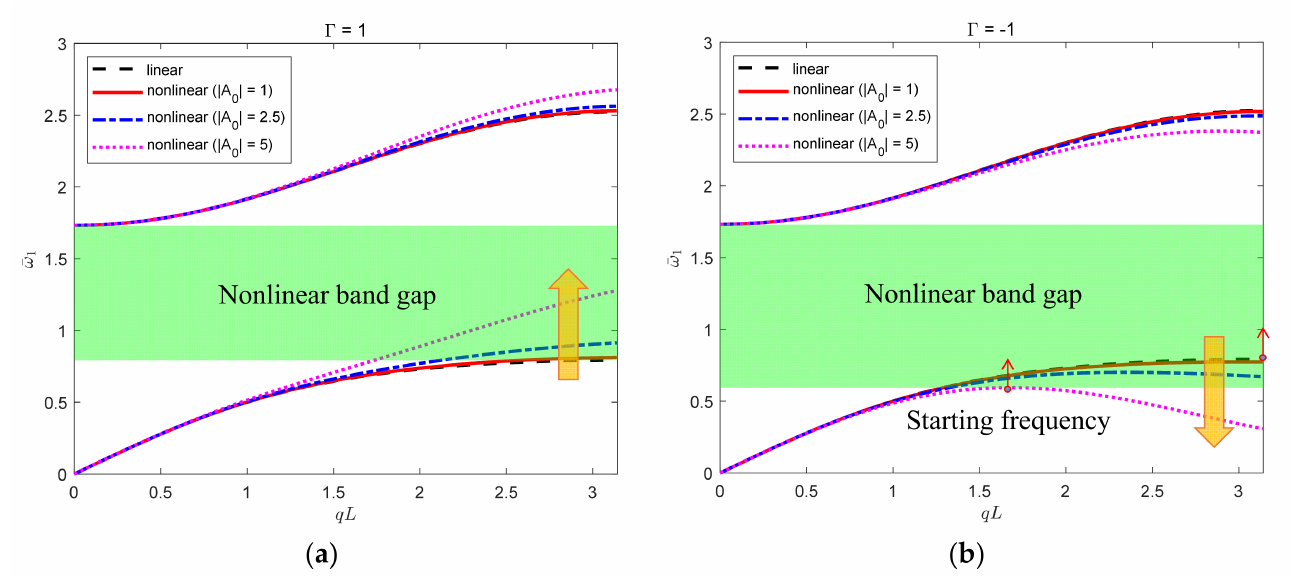
Figure 5. Band structure for a nonlinear mass-in-mass system changing with the wave amplitude | A 0 | . The fixed degree of nonlinearity is ( a ) Γ = 1 and ( b ) Γ = − 1. The small parameter is set as ε =